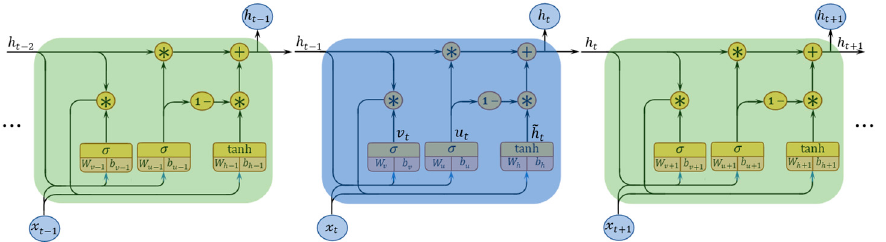
by tanh ) as the activation of output.